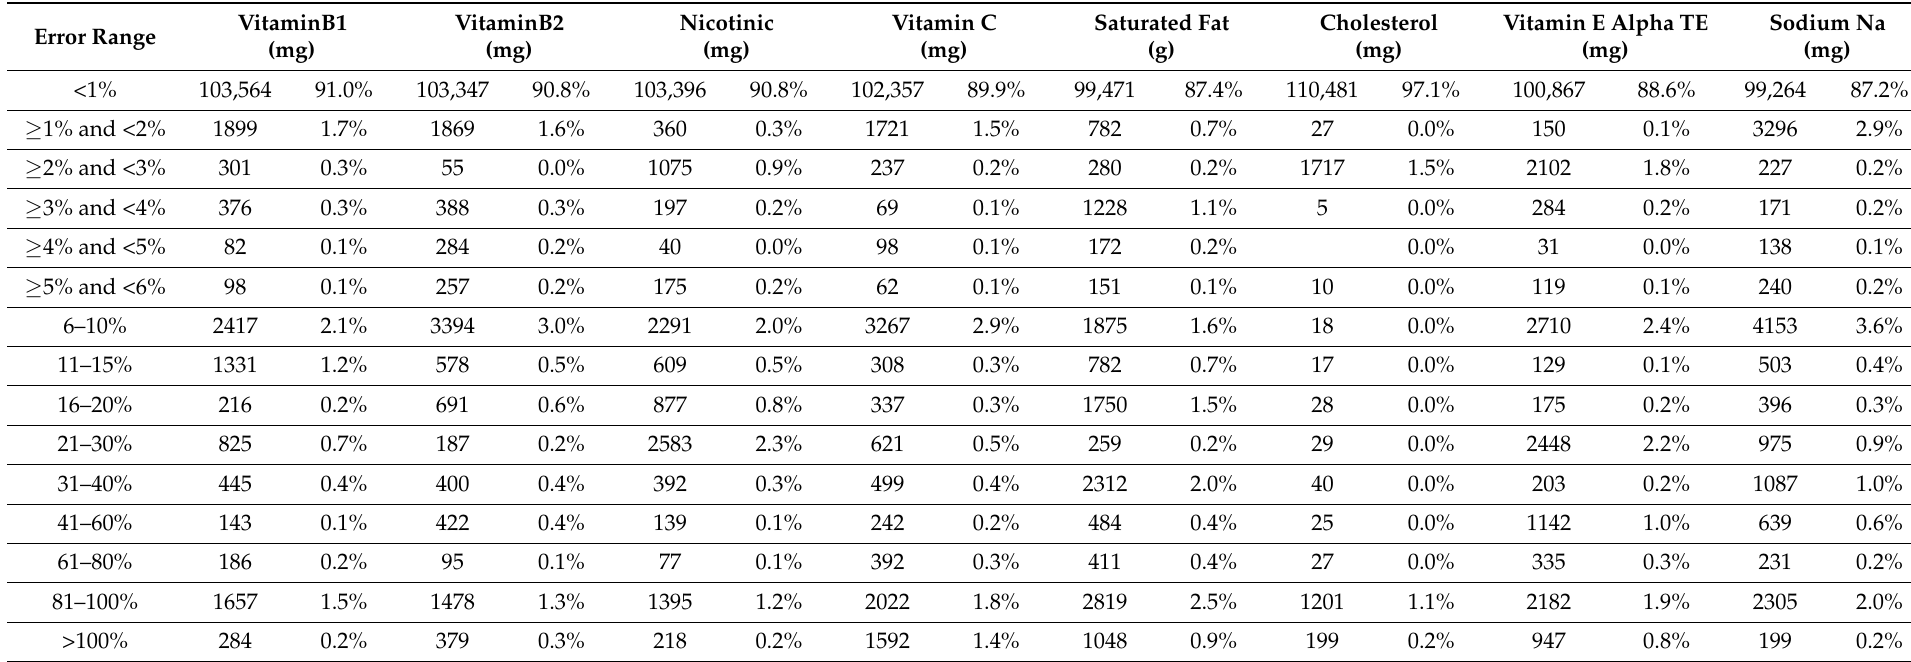
Table 5. Discrepancy comparison table of NNHS analysis with the results of this study in the food_wt_and_nutrients